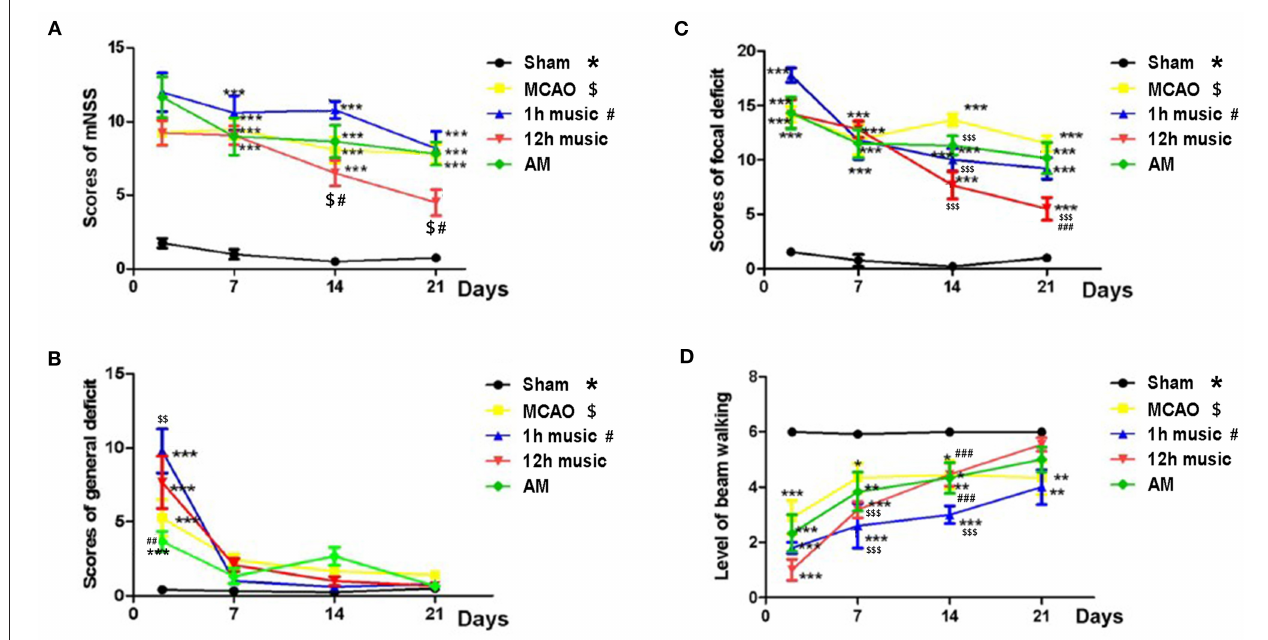
FIGURE 2 | Effects of music on neurobehavioral outcomes of MCAO rats. (A) mNSS, (B) general deficit scores, (C) focal deficit scores, and (D) beam walking level of the sham, MCAO, 1h music, 12h music, and AM rats. Music therapy was initiated on the eighth day after MCAO. * , $ , # p < 0.05; ** , $$ , ## p < 0.01; *** , $$$ , ### p < 0.001. The asterisk, dollar sign, and number symbol represent a significant difference compared with the sham, MCAO, and 1h music groups, respectively.